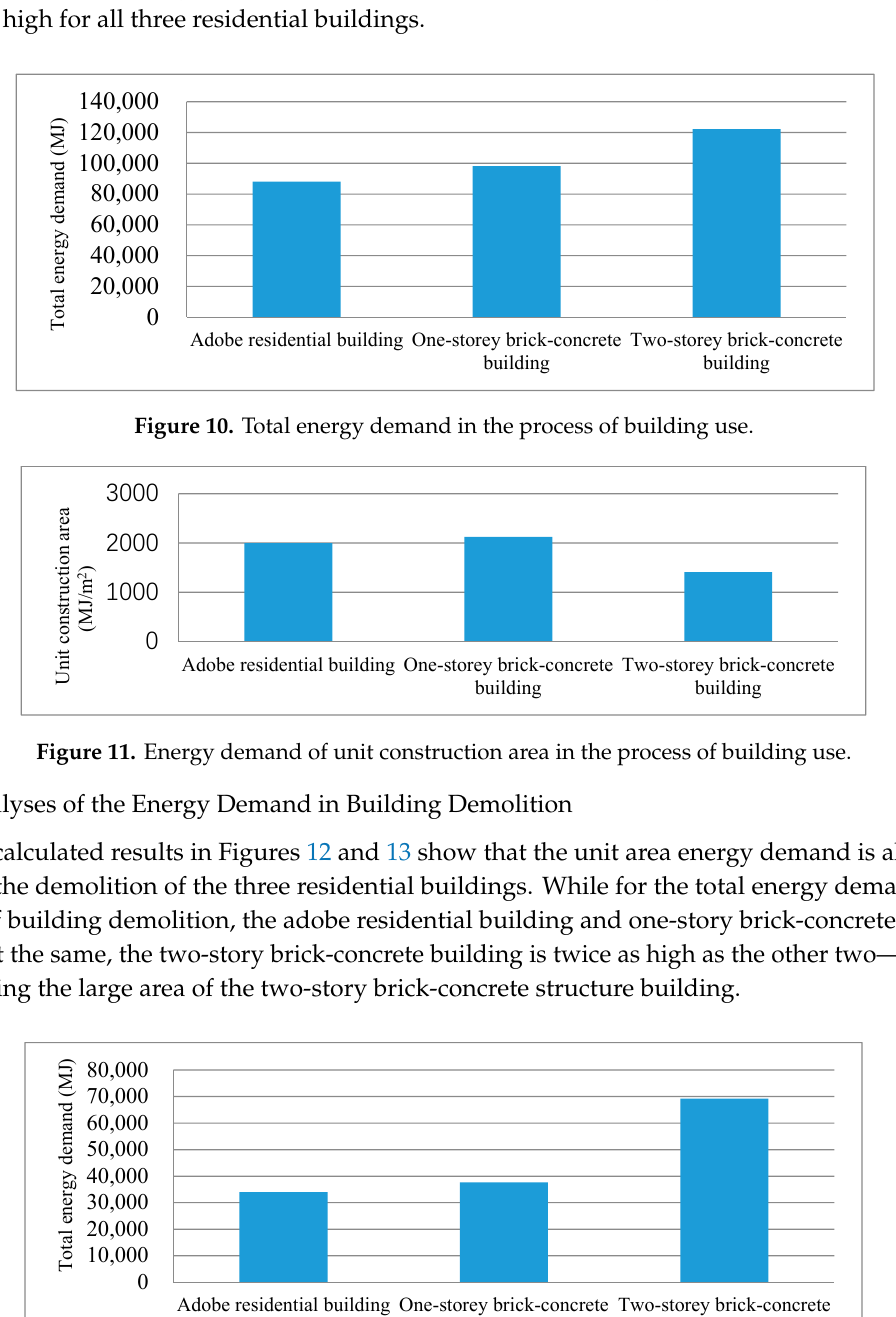
Figure 13. Energy demand of unit construction area in the process of building demolition. Figure 14. Total energy demand in the process of waste disposal.